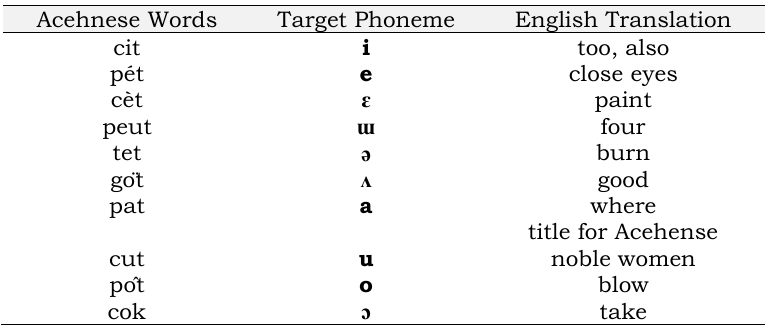
Table 1. Acehnese words used to obtain target